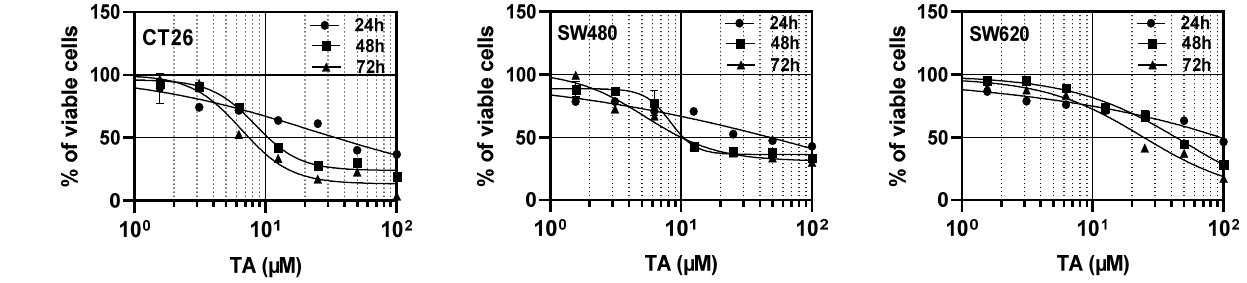
Figure 1. TA decreases the viability of CT26, SW480, and SW620 CRC cells in a dose- and time- dependent manner. Cells were exposed to increasing concentrations of TA (from 0 to 100 µM) for 24 h, 48 h, and 72 h. Cell viability was determined by CV assay and expressed as a percentage of the control (DMSO). Dose–response curves were plotted at the different treatment time points in the 3 cell lines with 4-parameter non-linear regression using GraphPad prism software. Each point of the curves represents the mean percentage of viable cells ± SD of 3 independent experiments, with 5 replicates per condition. Table 1. TA IC 50 values were determined after 24 h, 48 h, and 72 h of treatment in CRC cell lines. Statistical significance was determined by one-way ANOVA, followed by Tukey’s test for multiple comparison. *** p <0.001, **** p <0.0001 vs. CT26 cells at 24 h; #### p <0.0001 vs. SW480 cells at 24 h; $$$ p <0.001, $$$$ p <0.0001 vs. CT26 cells at 48 h; ££££ p <0.0001 vs. SW480 cells at 48 h; ¥¥¥¥ p < 0.0001 vs.